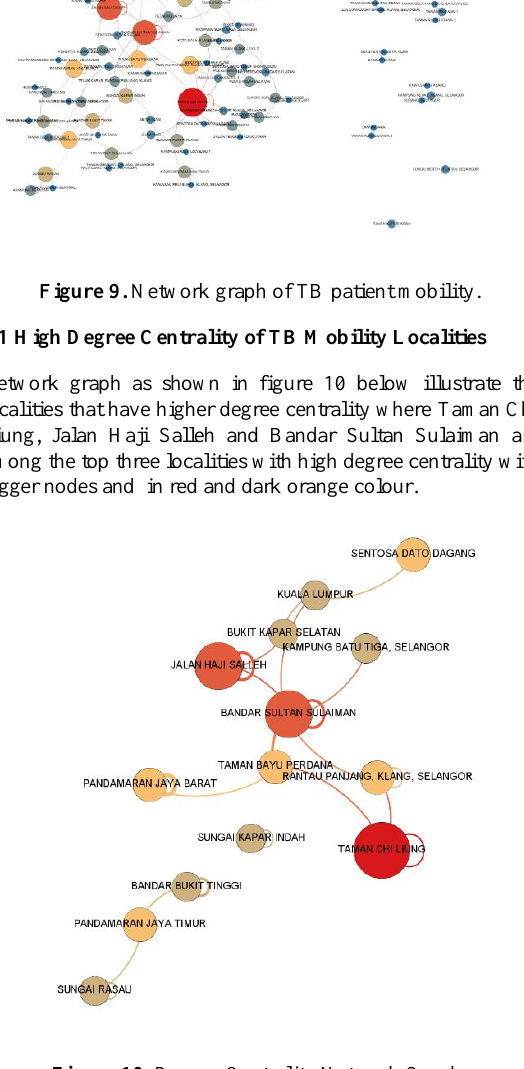
Figure 10. Degree Centrality Network Graph.